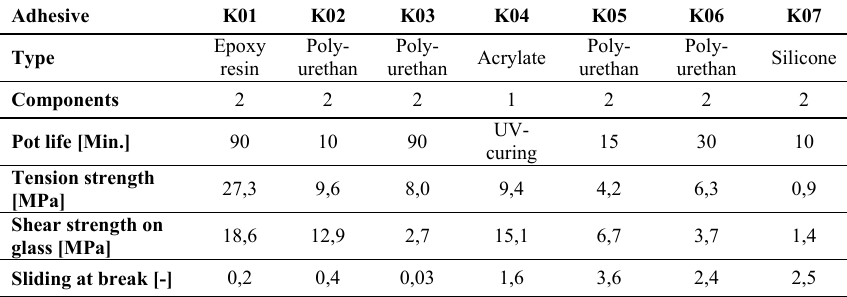
Table 3: Properties of the selected adhesives (tension and shear strength are 5% fractiles)